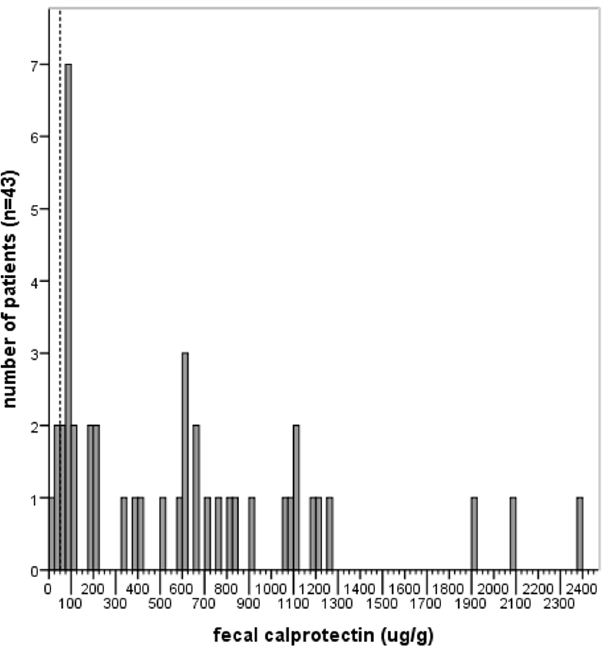
Fig 3. Distribution of faecal calprotectin levels in patients with cystic fibrosis (CF). The upper normal limit for faecal calprotectin (50 ug/g) is indicated by the dashed line.